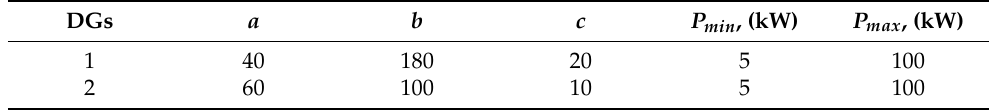
Table 1. Generation characteristics of the two